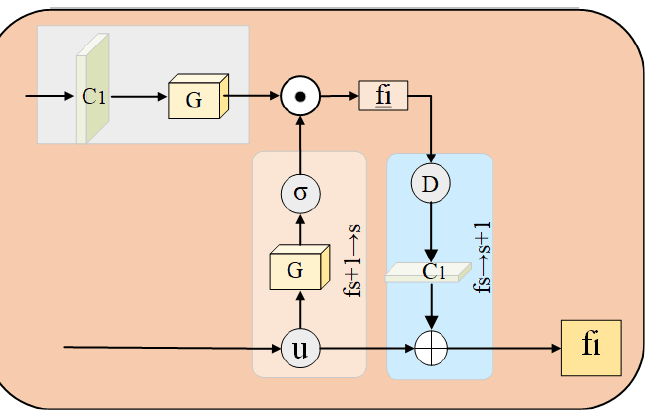
Figure 6. The architecture of the feature enhancement network. C 1 is the 1 × 1 convolution ker- nel.